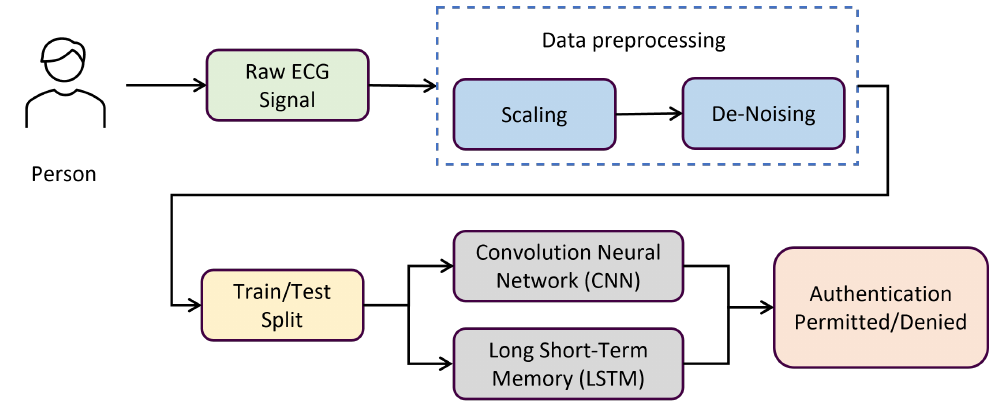
Figure 3. Block diagram proposed